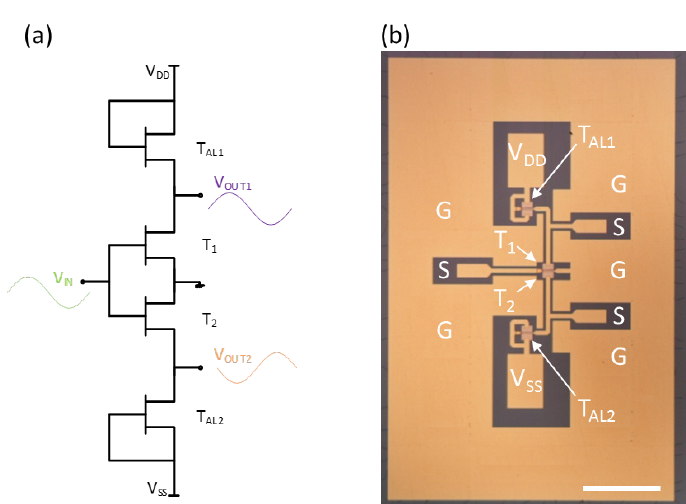
Figure 2. ( a ) Schematic circuit diagram of the balun and ( b ) photography of the balun highlighting its layout. Scale bar is 180 µ m.